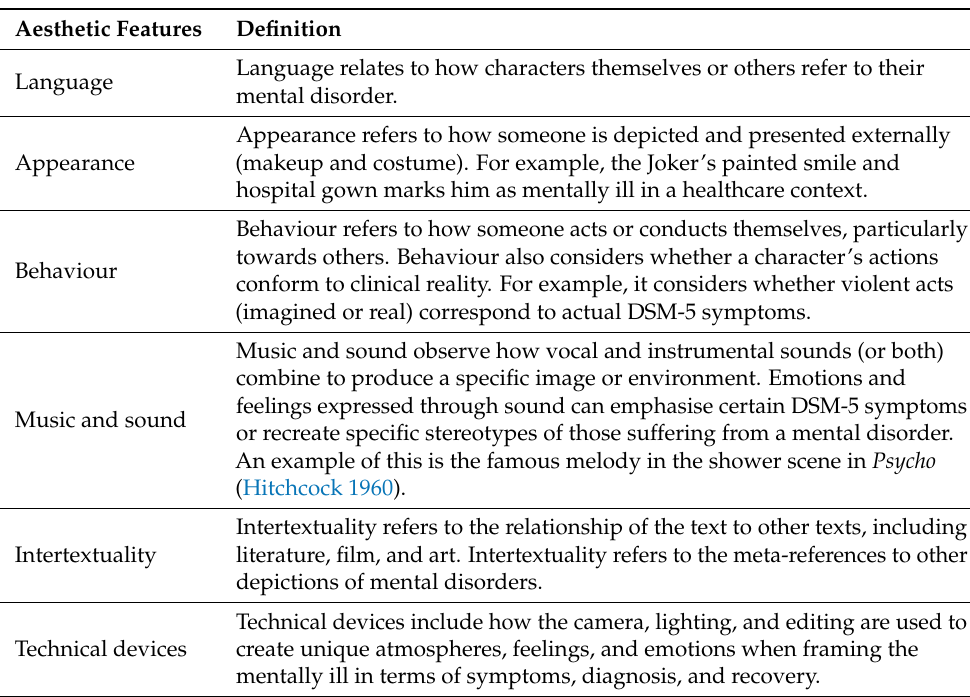
Table 1. Aesthetic features and definitions. Source: based on Camp et al.